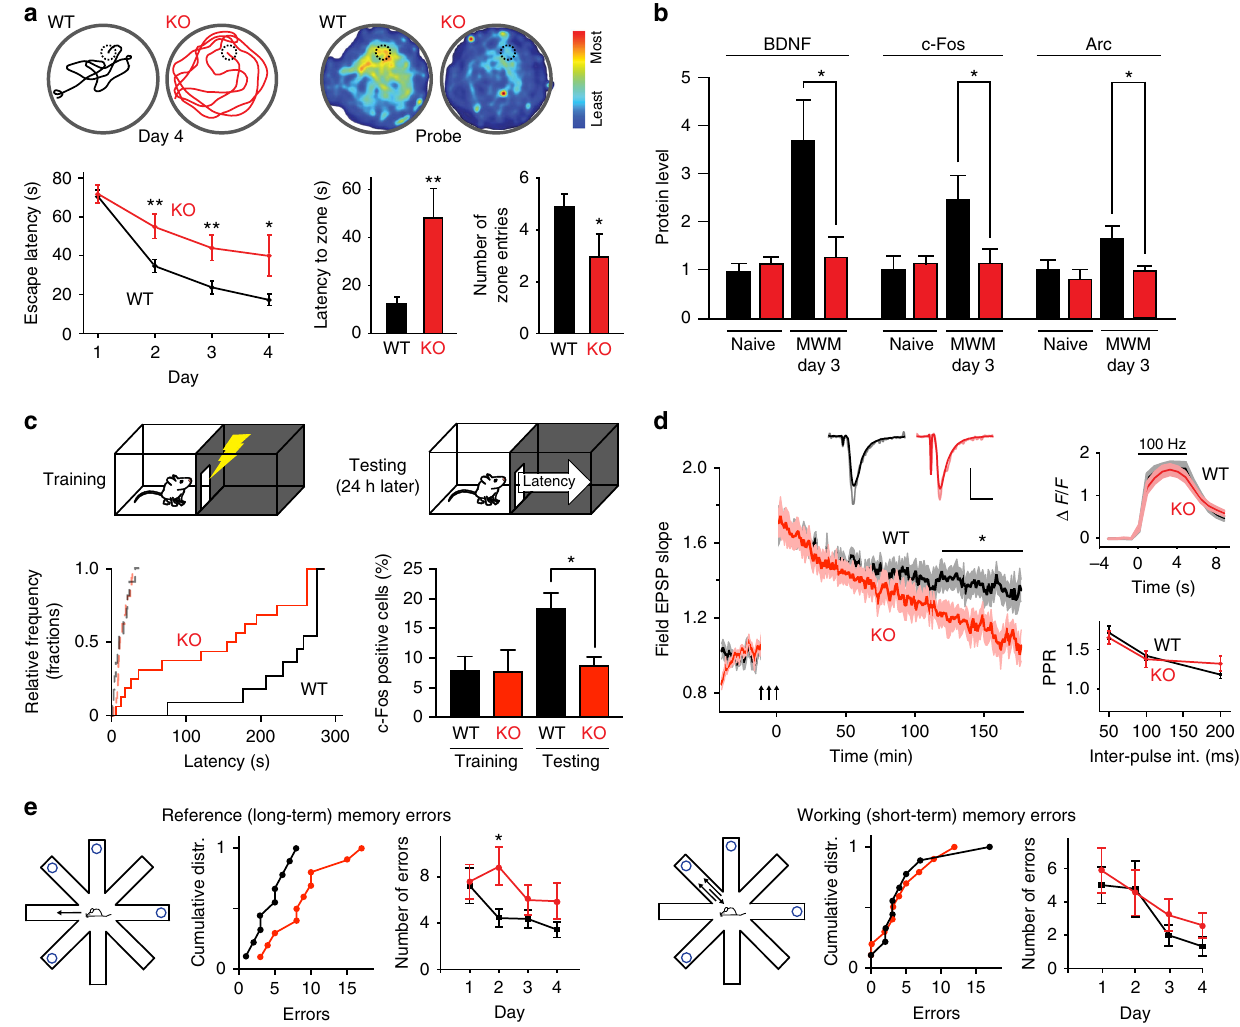
Fig. 1 Spatial memory, CREB-dependent gene expression, L-LTP are impaired in γ CaMKII-de fi cient mice. a Spatial memory acquisition and retrieval were tested with the Morris Water Maze (MWM). Bottom left, mean escape latencies to reach a hidden platform were plotted against training day (4 trials per day) for WT mice (black, n = 21 for 1st 3 days, 12 for 4th day) and γ CaMKII KO mice (red, n = 19 for 1st 3 days, 10 for 4th day). Top left, representative path used by mice to reach hidden platform (dotted circle) during the last trial of Day 4. Top right, activity histogram representing average proportion of total time spent by mice during probe trial; γ CaMKII KO mice ( n = 10), WT ( n = 12); scale at far right, amount of time spent at different locations. Bottom middle, latency to reach platform zone during probe trial. Bottom right, number of zone entries during probe trial. b Western blot analysis of BDNF, c-Fos, and Arc expression in the hippocampus of WT (black, n = 9) and KO (red, n = 7) mice. Animals sacri fi ced 1 h after end of MWM training on 3rd day. c Inset, schematic depiction of inhibitory avoidance test. Left graph, cumulative distribution of latencies to enter the dark compartment before conditioning (dashed lines) and 24 h post conditioning (solid lines). Conditioning done by administration of a mild shock in the dark compartment. Right bar graph, percentage of c-Fos + neurons in CA1 assessed 1 h after test trial. d Left, late-phase LTP (L-LTP) induced by three trains of tetanic stimulation (100 Hz, 1 s), spaced by 5 min intervals 24,37 , with timing denoted by the gap in the fi eld EPSP trace ( n = 6 mice for each group). Superimposed representative EPSPs show the basal EPSP (bold color) and the EPSP at 165 min (muted color) after L-LTP induction. Calibration bars, 1 mV and 10 ms. Top right, Fluo-4 Ca 2 + responses ( Δ F / F ) to 5 s of 100 Hz fi eld stimulation in acute hippocampal slices from wild-type and γ CaMKII KO mice. Bottom right, paired-pulse ratio (slope of second EPSP/slope of fi rst EPSP) plotted with interpulse intervals of 50, 100, and 200 ms ( n ≥ 9 slices). e Radial arm maze behavior. Reference and working memory on day 2, re fl ecting various aspects of spatial memory 24 h after fi rst exposure to maze, were assayed respectively by recording the number of entries into arms that were never baited (reference memory) or re-entries into arms that were initially baited (working memory) ( n ≥ 9 for both genotypes). Statistical analysis was performed with one-way ANOVA followed by Holm – Sidak post hoc test unless otherwise noted. * p ≤ 0.05, ** p ≤ 0.01, *** p ≤ 0.001. Error bars represent SEM 4.58 ± 0.57 for γ CaMKII KO, p > 0.9), paired-pulse ratio, or day 1), but failed to show memory savings 24 h later (Fig. 1e). somatic Ca 2 + in fl ux in response to 100 Hz stimulation 38 . In contrast, KO and WT mice committed similar numbers of Our fi nding of reduced L-LTP with intact E-LTP suggested that short-term (working memory) errors. Likewise, further tests in γ CaMKII KO mice might display de fi cits in long-term (reference) the MWM indicated that de fi ciency in γ CaMKII KO performance memory but not short-term (working) memory. In the radial arm speci fi cally re fl ected a spatial learning de fi cit; our behavioral maze, γ CaMKII KO mice were no different than WT animals results could not be otherwise explained by reluctance to upon fi rst presentation of arm locations (reference “ errors ” , swim, swimming speed, wall-hugging behavior, muscle function NATURE COMMUNICATIONS | (2018)